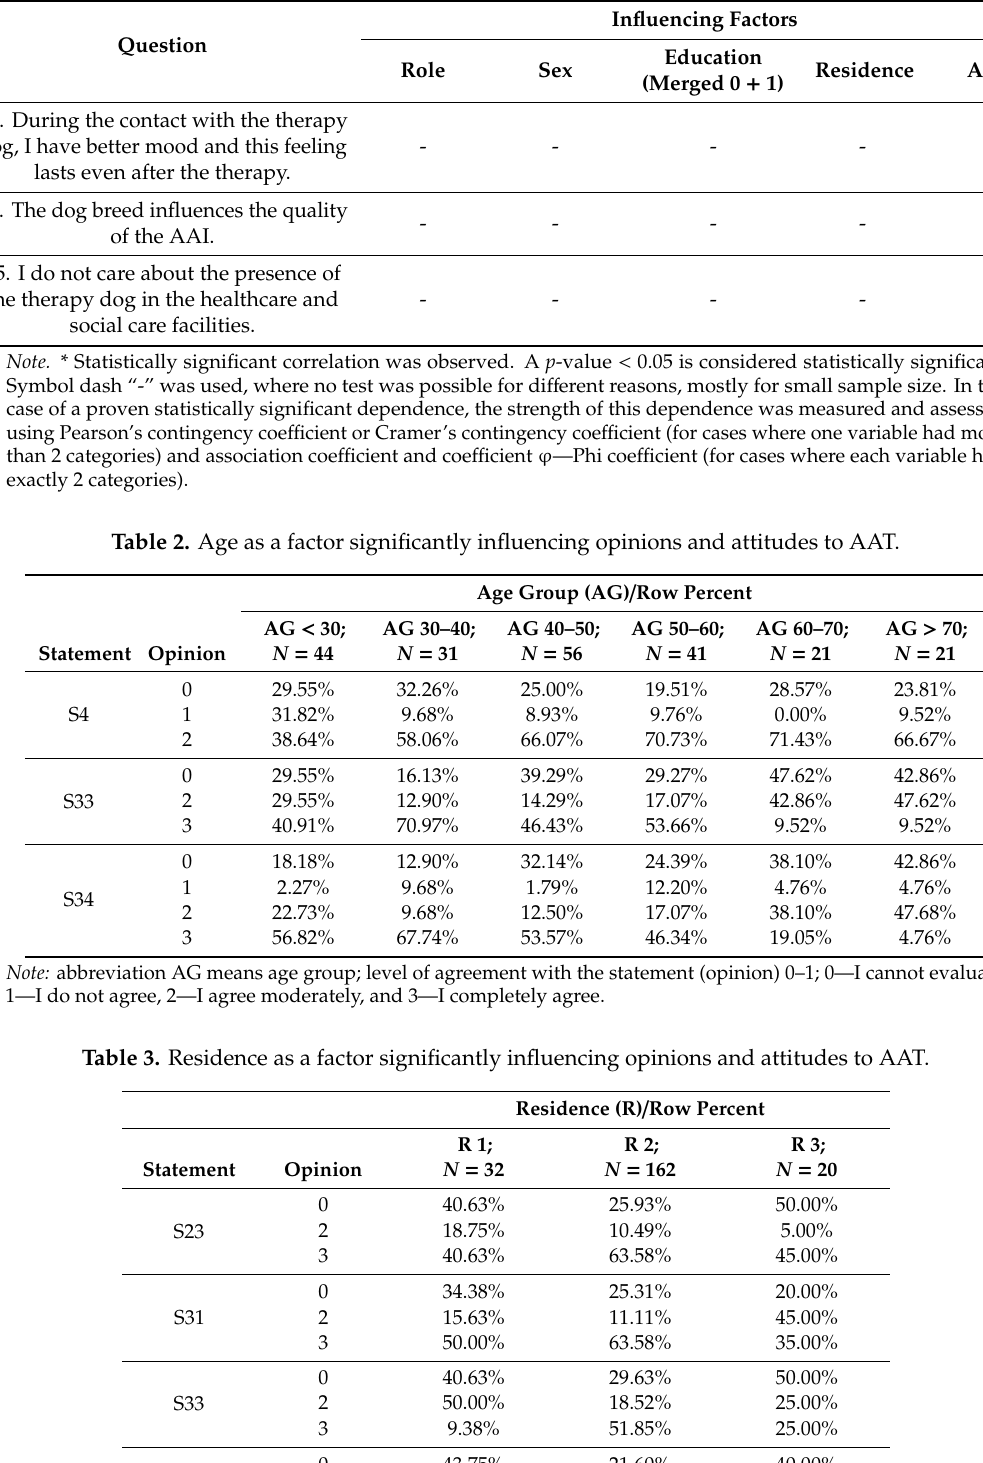
Influencing Factors Education